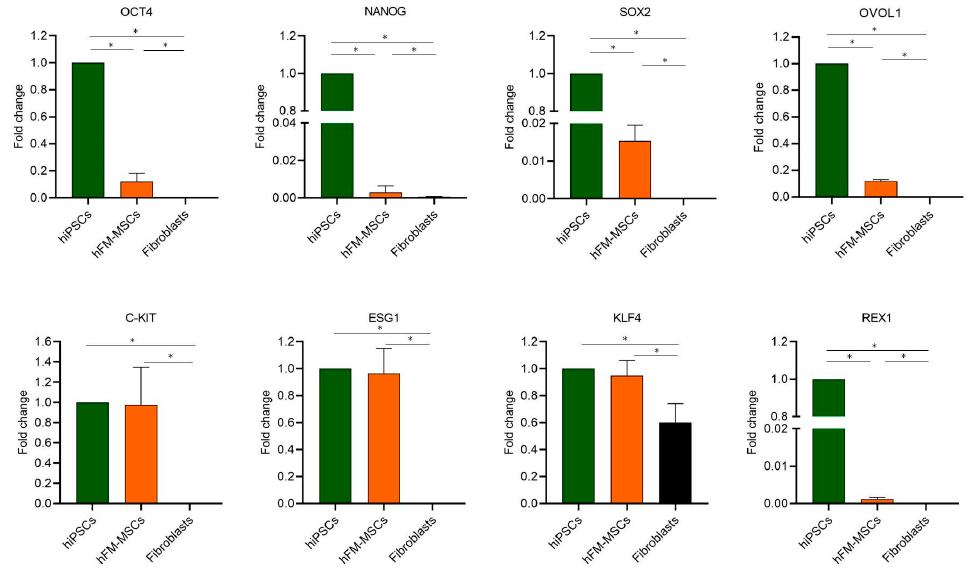
Figure 1. Gene expression analysis of pluripotency markers in hESC, hFM-MSCs, and hiPSCs. mRNAs of KLF4 , ESG1 , OVOL1 , and REX1 were detected by qPCR. The fold changes were expressed in relation to hiPSCs. 18S was used as the reference gene. Fibroblasts were used as the negative control. The graphs show the mean ± SD of three independent experiments * p < 0.05.